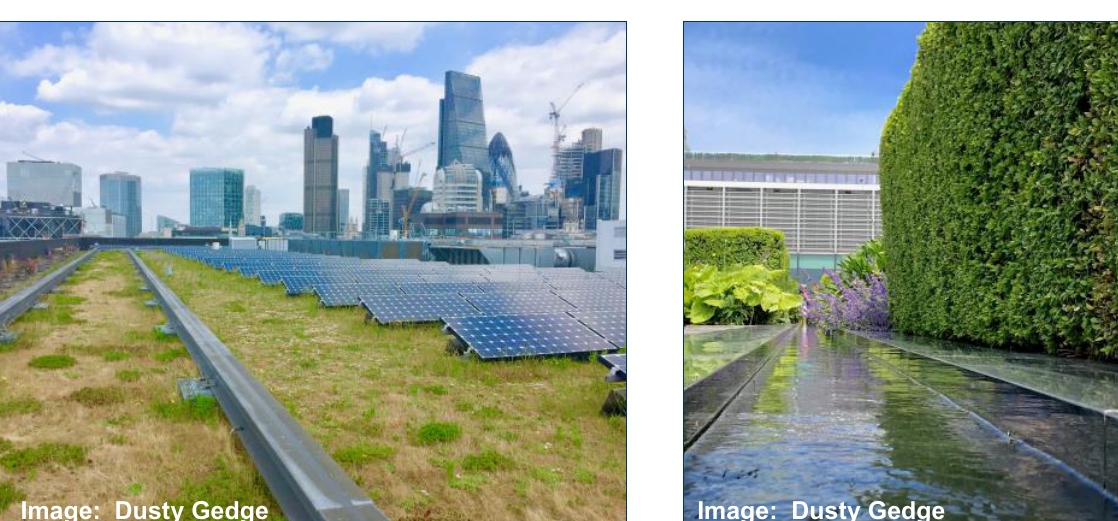
Image: Dusty Gedge